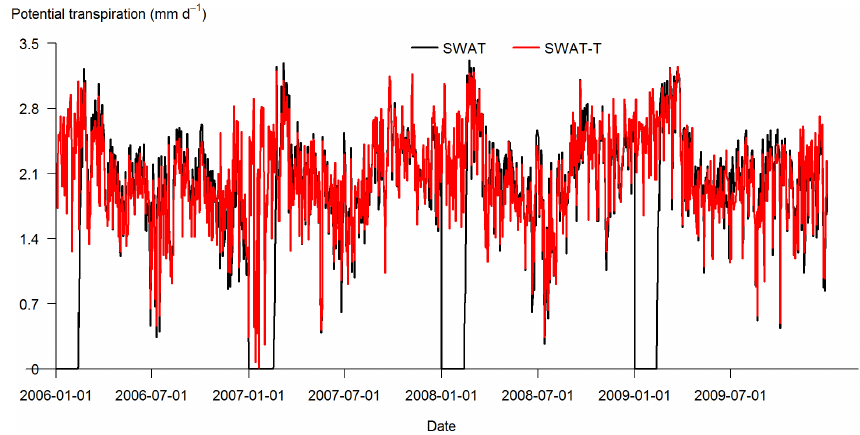
Figure 6. Comparison of Penman–Monteith-based daily potential transpiration simulated by the SWAT-T and the standard SWAT models for grassland. Note that the heat unit scheduling is used in the standard SWAT model.